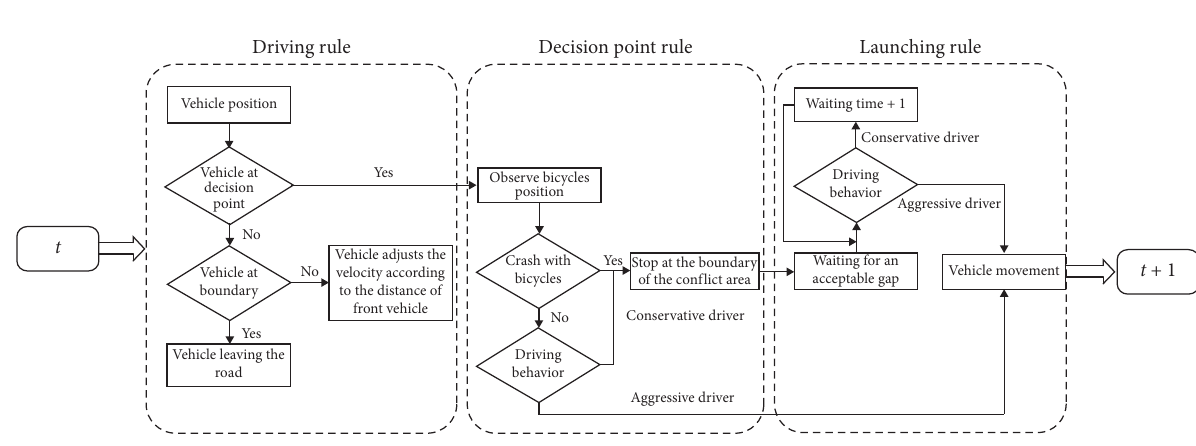
Figure 4: Complete mixed-flow CA model framework. Table 1: The simulation parameters in mixed-flow CA